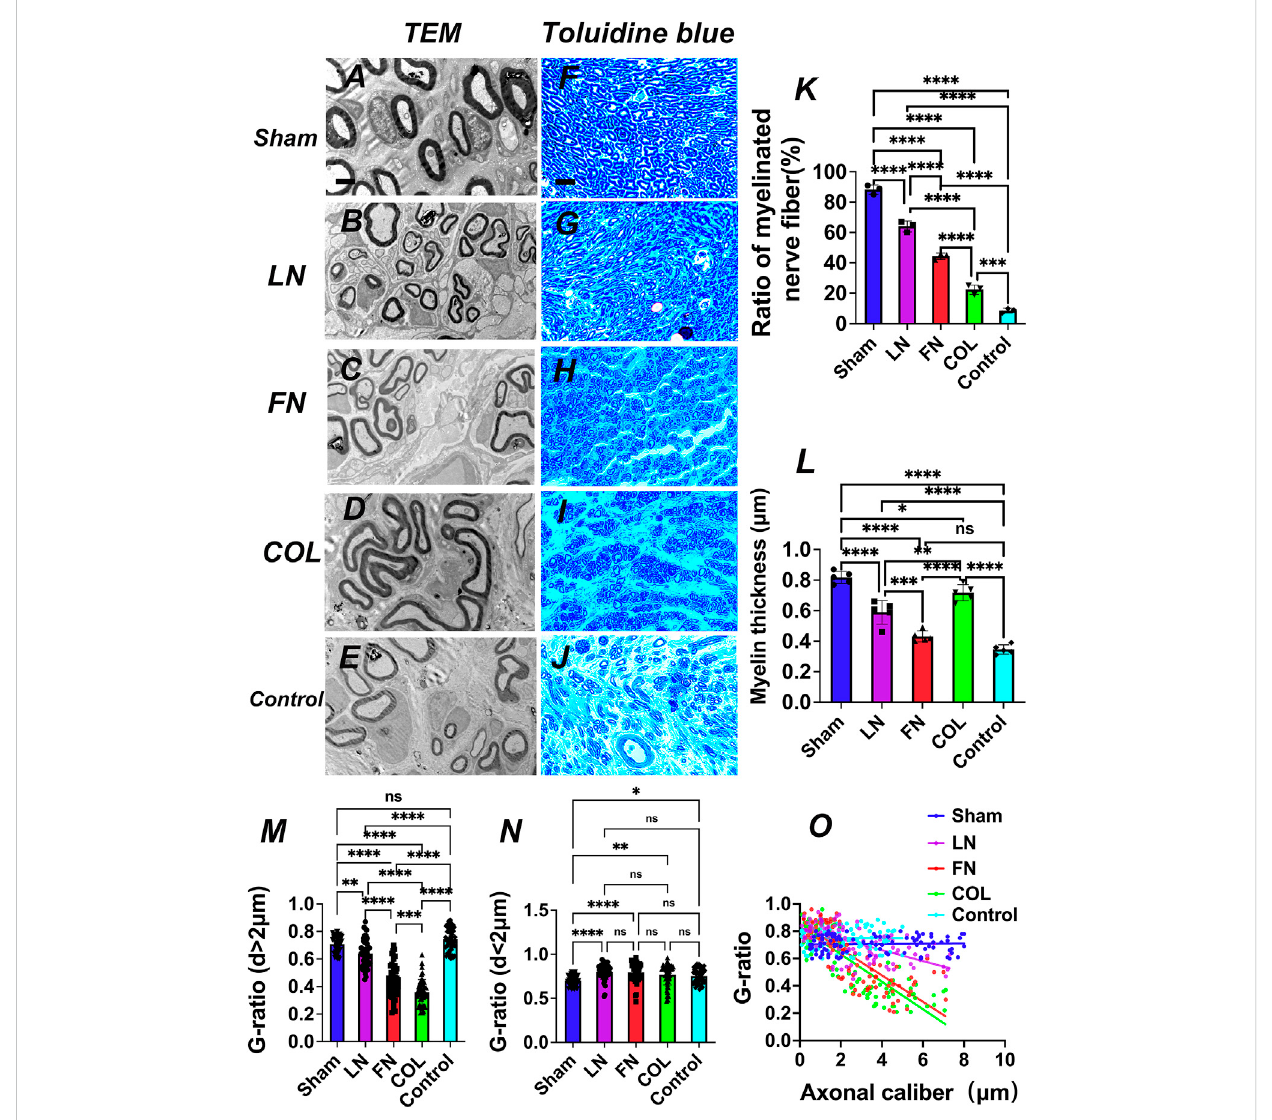
FIGURE 6 Axon and myelinregeneration atthefourthweek after model construction.TEM images (A – E) and TBstaining images (F – J) ofaxon regeneration at theimplanted graft. Quantitativeanalysis of theproportion ofmyelinatednerve fi bers[ (K) , n =3].Quantitativeanalysisofmyelin sheaththickness[ (L) , n = 5].G-ratioindexandnervefunctionrecovery:Quantitativeanalysis oftheG-ratioofaxonswithadiameter > 2 μ m[ (M) , n =50]andaxonswithadiameter of < 2 μ m [ (N) , n = 50) and a scatter plot based on axon diameter (X-axis) and G-ratio (Y-axis) [ (O) , n = 100]: the G-ratio of the LN group is closer to thebest G-ratio (0.6). * p < 0.05, ** p < 0.01, *** p < 0.001, **** p < 0.0001, ns p > 0.05. One-way ANOVA withTukey ’ s post-hoc test.Scale bar (A – E) =2 μ m, Scale bar (F – J) = 700 μ